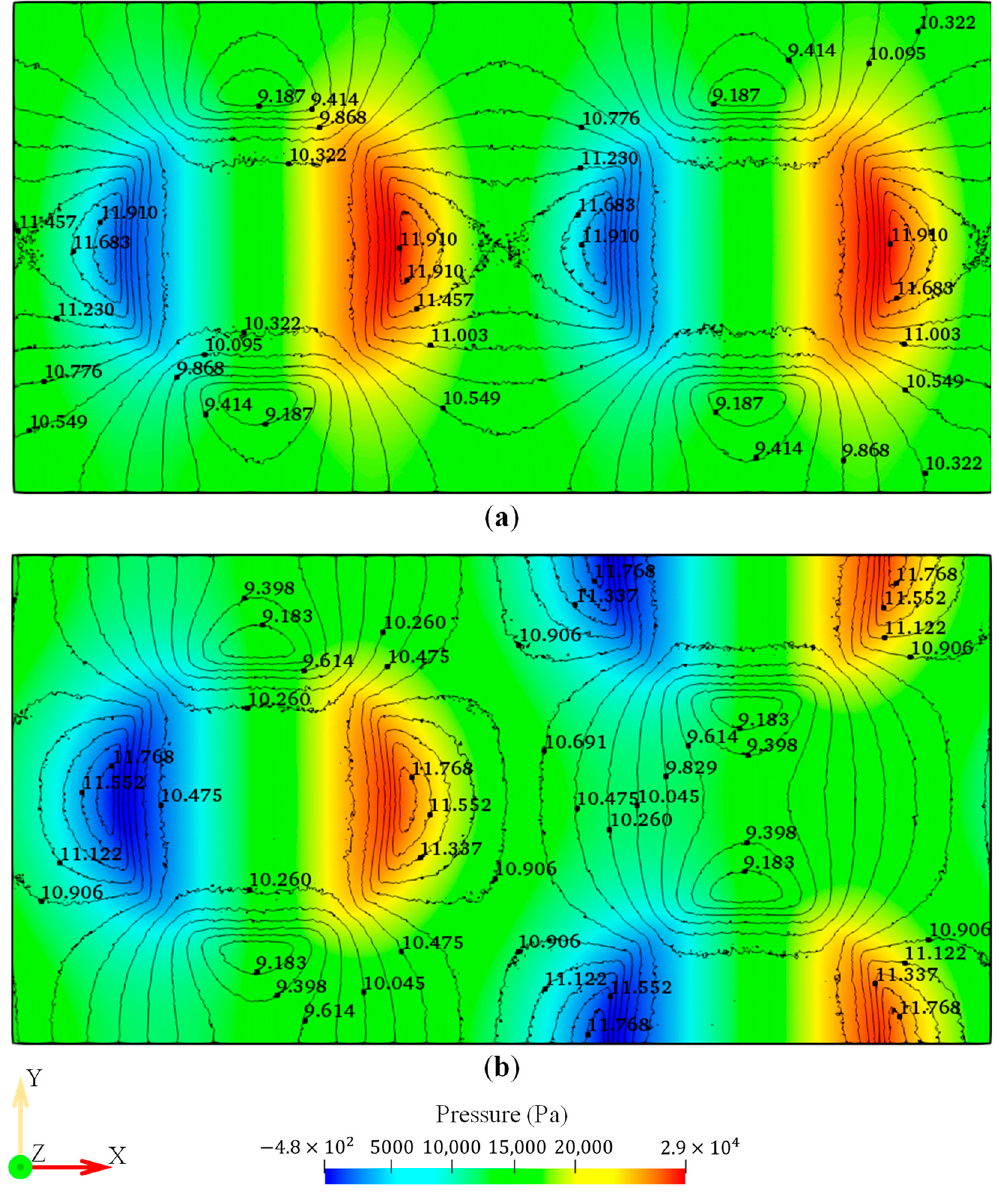
Figure 23. Velocity (line contours) and pressure (coloured contours) distributions at the mid-plane between the die and workpiece: ( a ) grid array pattern; ( b ) crossing array pattern. Note that the unit of velocity is mm/s.